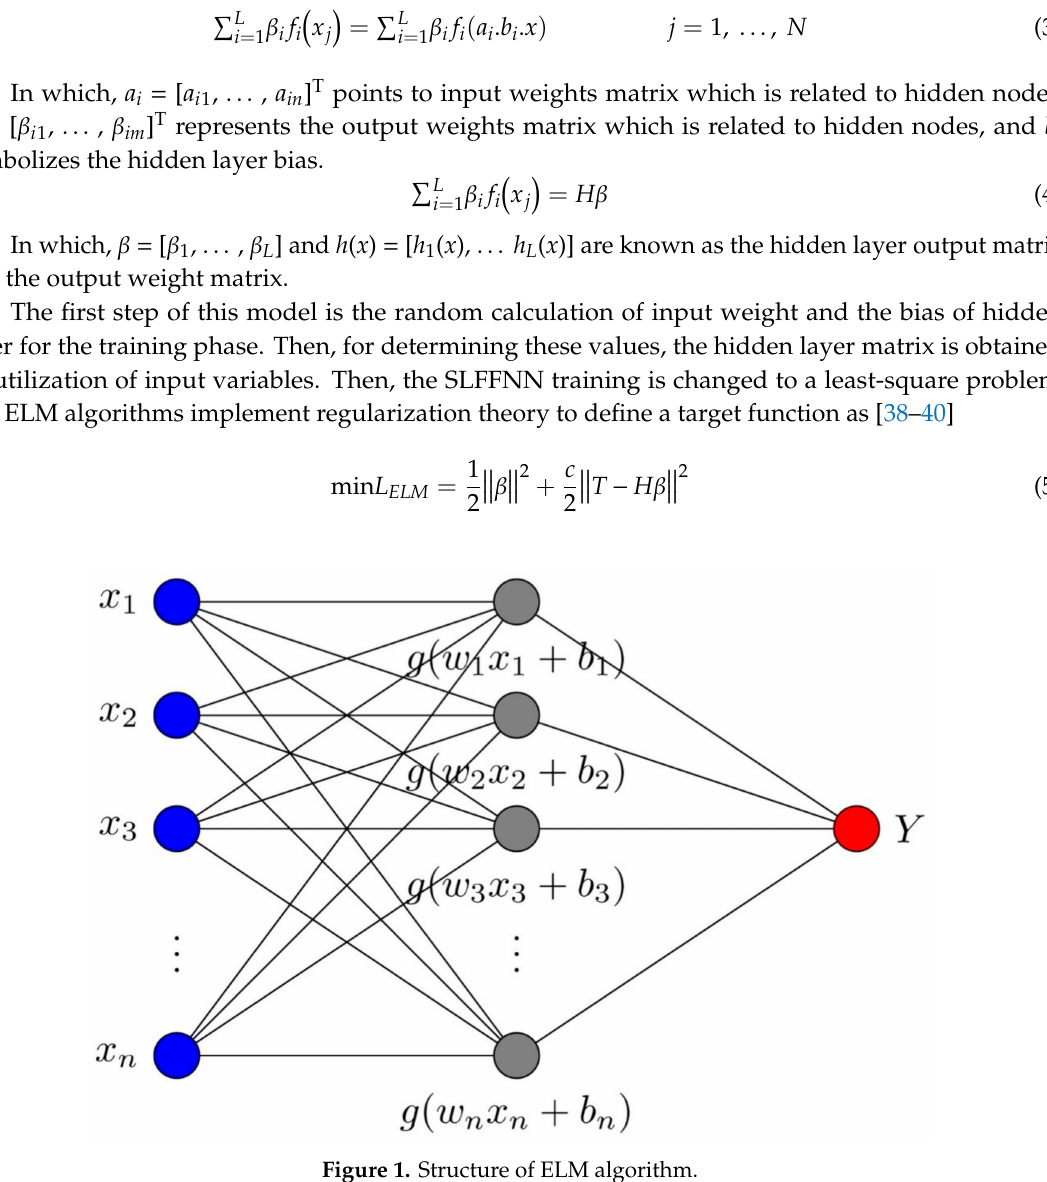
Figure 1. Structure of ELM